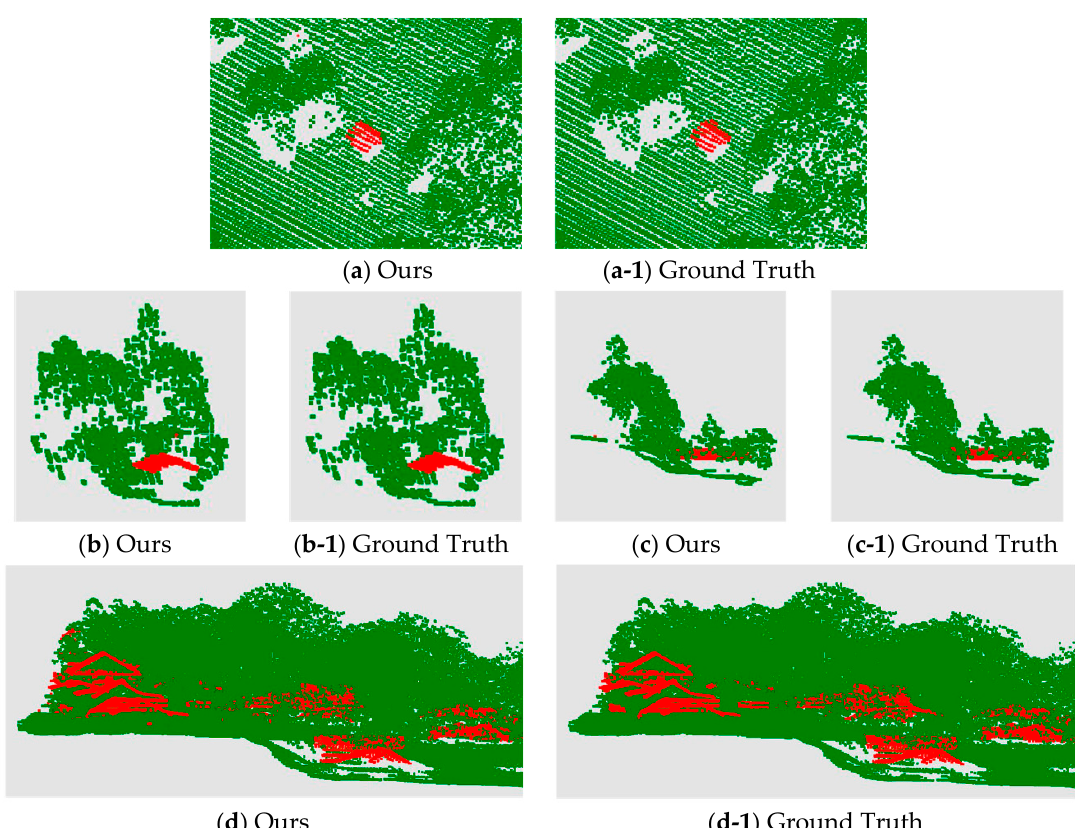
Figure 13. The visualization of complicated